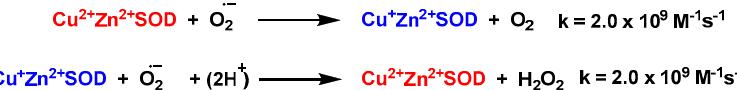
Figure 32. Superoxide dismutation reaction catalysed by Cu,Zn-SOD.